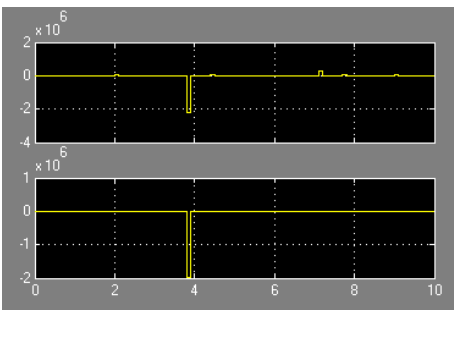
Figure 5. model with using ANN of Scope 2 ‘G 2 (u)’